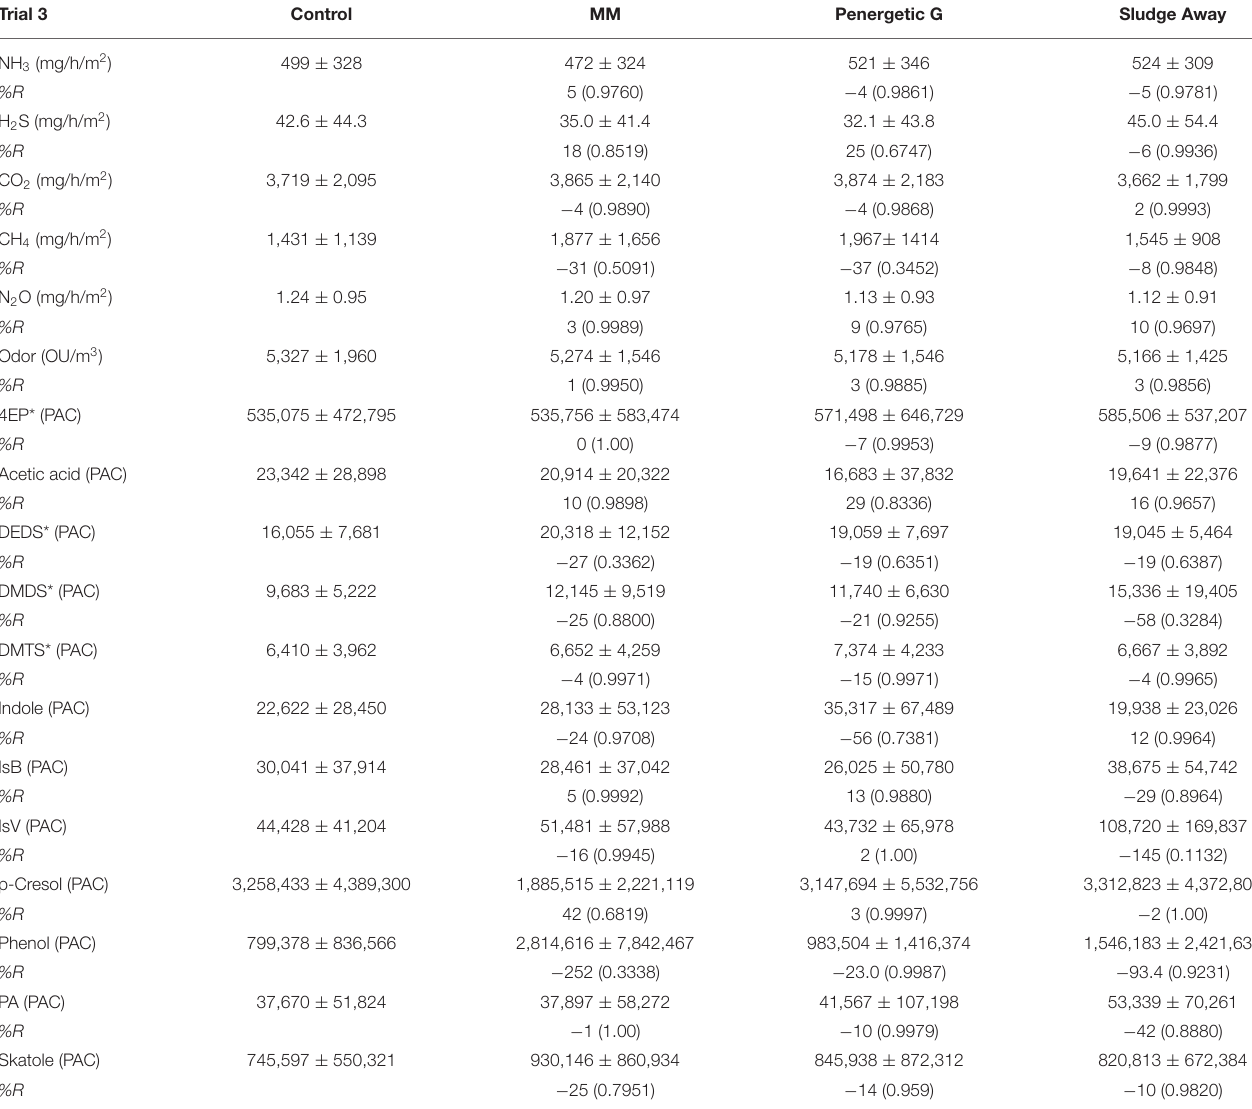
TABLE 6 | Trial 3-Comparison of averaged gaseous emissions from three manure sources (farms) with their standard deviations. Trial